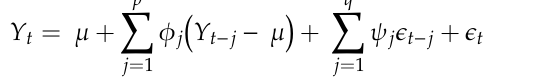
Figure 5. Decomposition of the hourly kWh consumption from September 2016 to September 2019.